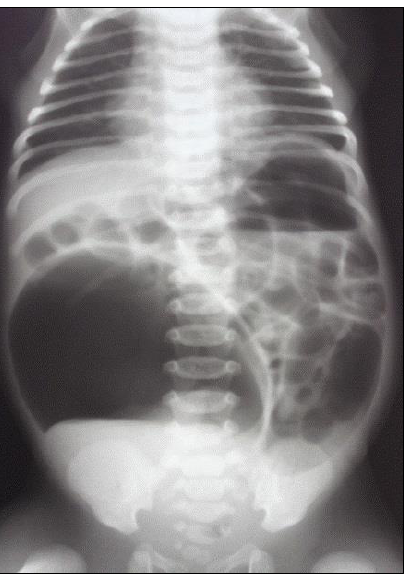
Figure13: Big gas shadow of congenital pouch colon pushing gut loops to left abdomen. Barium enema-An extended and essential supple- ment part of plain radiograph First enema child should receive should be barium enema.